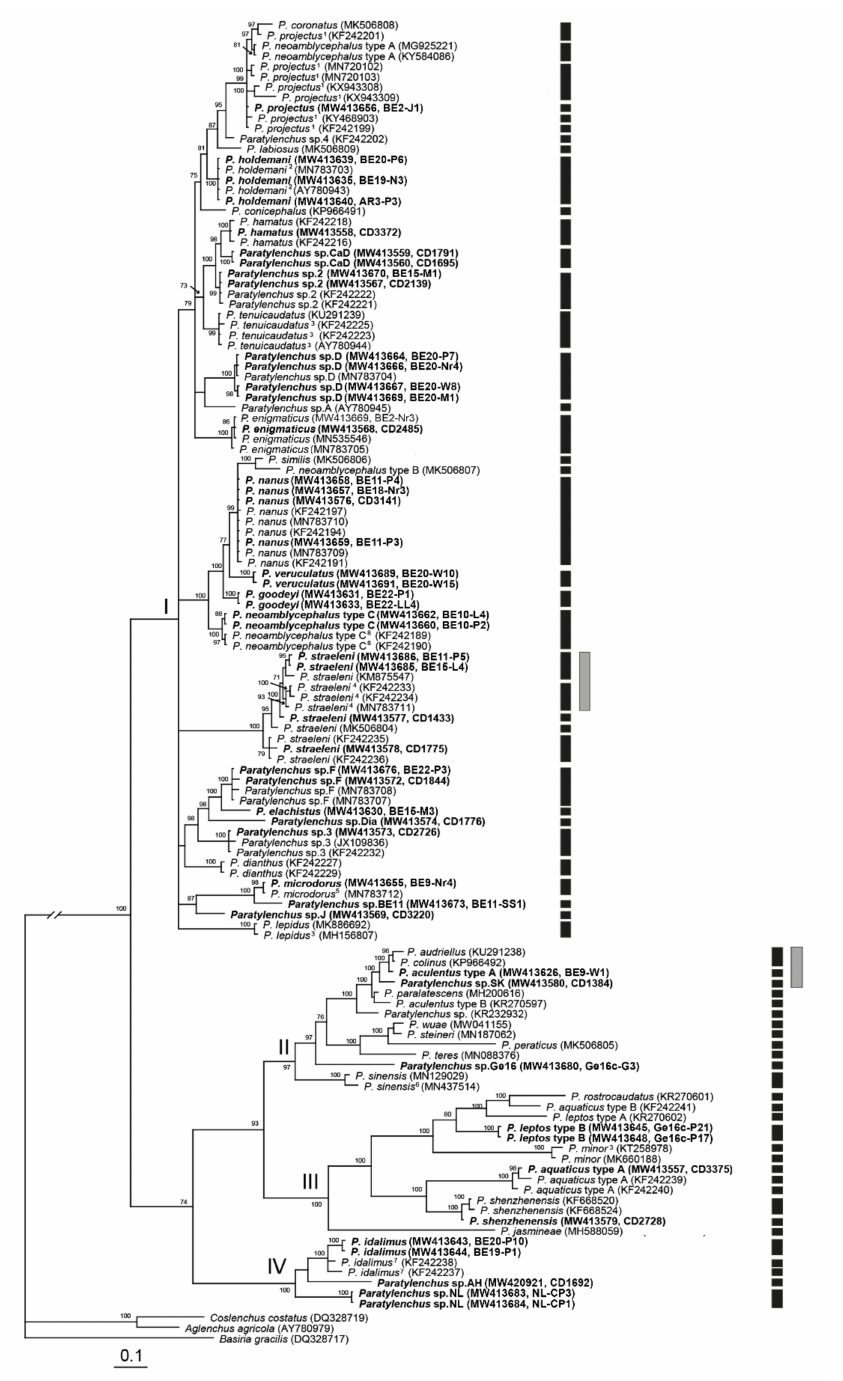
Figure 16. Phylogenetic relationships within populations and species of Paratylenchus , as inferred from Bayesian analysis using the D2-D3 of 28S rRNA gene sequence dataset with the GTR + I + G model. Posterior probability of more than 70% is given for the appropriate clades. Newly obtained sequences are indicated in bold. 1 = originally identified as P. nanus , 2 = originally identified as P. bukowinensis , 3 = originally identified as Paratylenchus sp., 4 = originally identified as Paratylenchus sp.8, 5 = originally identified as Paratylenchus sp.E, 6 = originally identified as Gracilacus sp. 7 = originally identified as Paratylenchus sp.5 and 8 = originally identified as Paratylenchus sp.6. Black and grey bars represent species boundaries estimated by generalized mixed-yule coalescent (GMYC) and Poisson tree process (bPTP) methods, respectively (only differences with GMYC